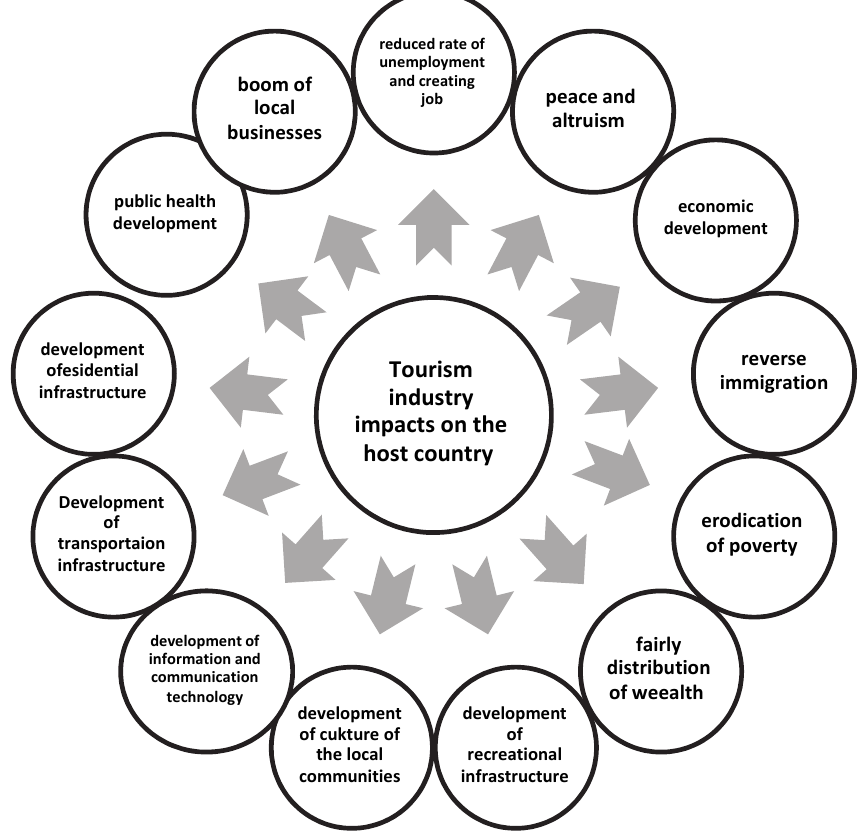
Fig. 1. Tourism industry impacts on the host